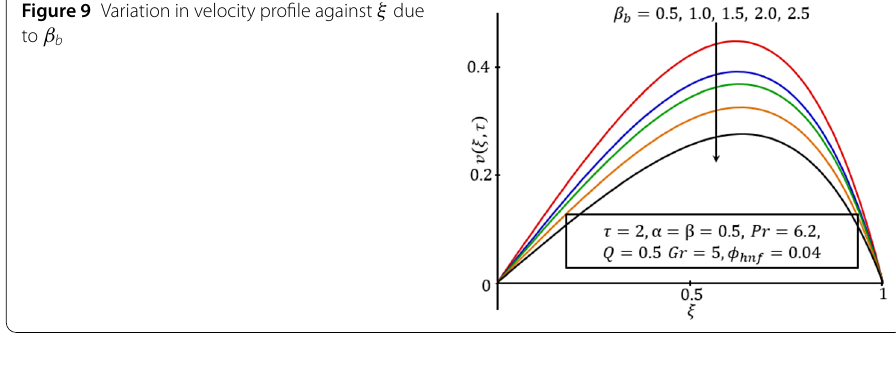
Figure 10 Variation in velocity profile against ξ due to